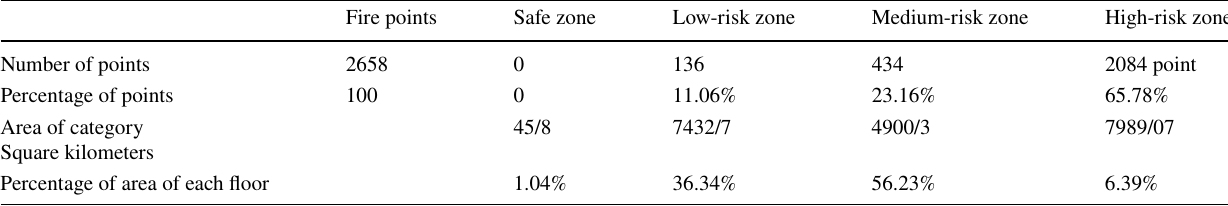
Table 3 Assessing the accuracy of fire risk areas